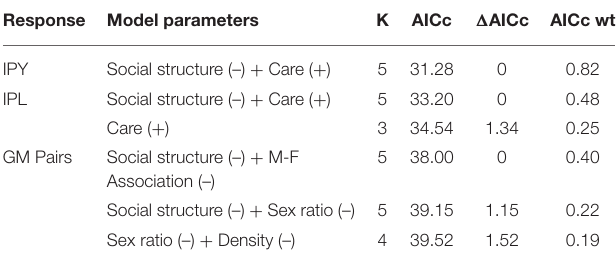
0.70 0.04 ( N 34 species; range: 0.40–1.00; median number of ± = pairs/species 16). =